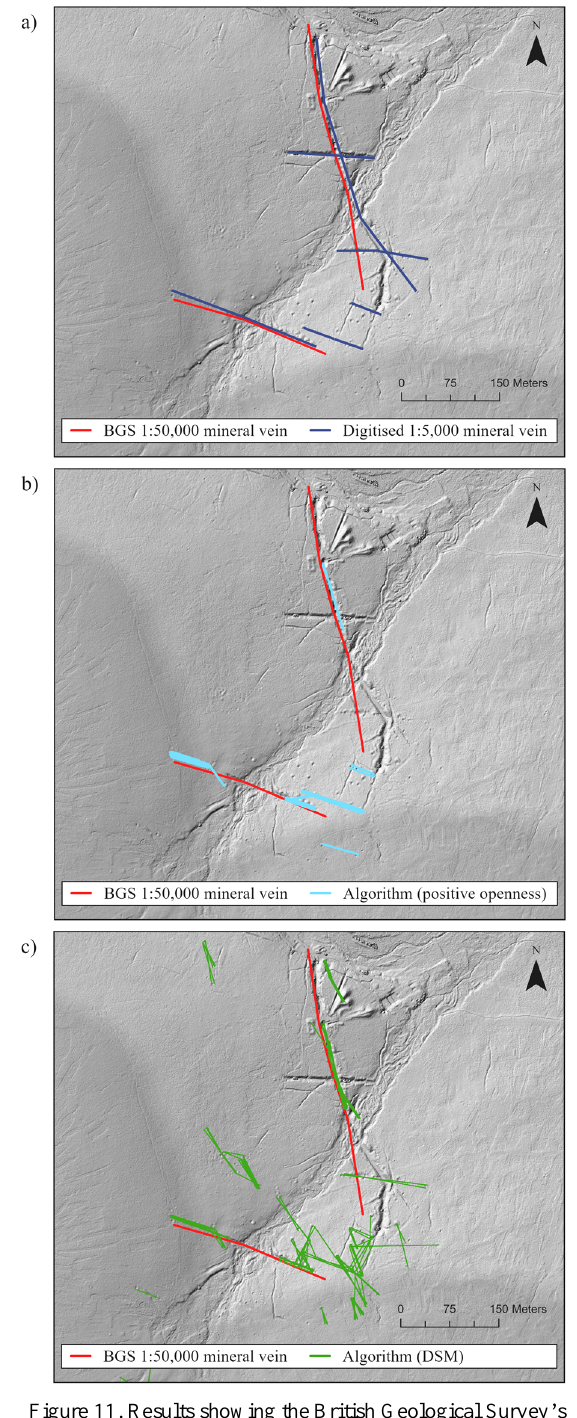
Figure 11. Results showing the British Geological Survey’s 1:50,000 linear geology layer compared to a) manually digitised high resolution lines and b) the lines generated by the automated algorithm. Geological Map Data BGS © UKRI 2020,